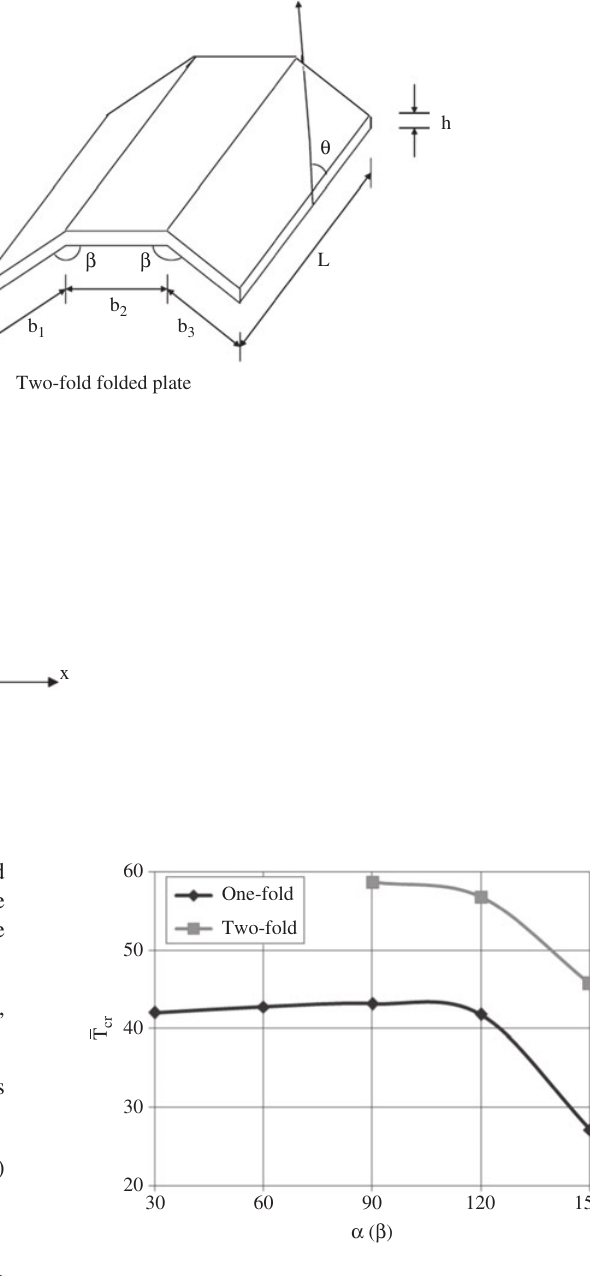
Figure 3 Effect of crank angles on the critical thermal buckling load for one-fold and two-fold laminated plates. Table 1 Effect of crank angles on the optimum fi ber orientations for one-fold and two-fold laminated composite